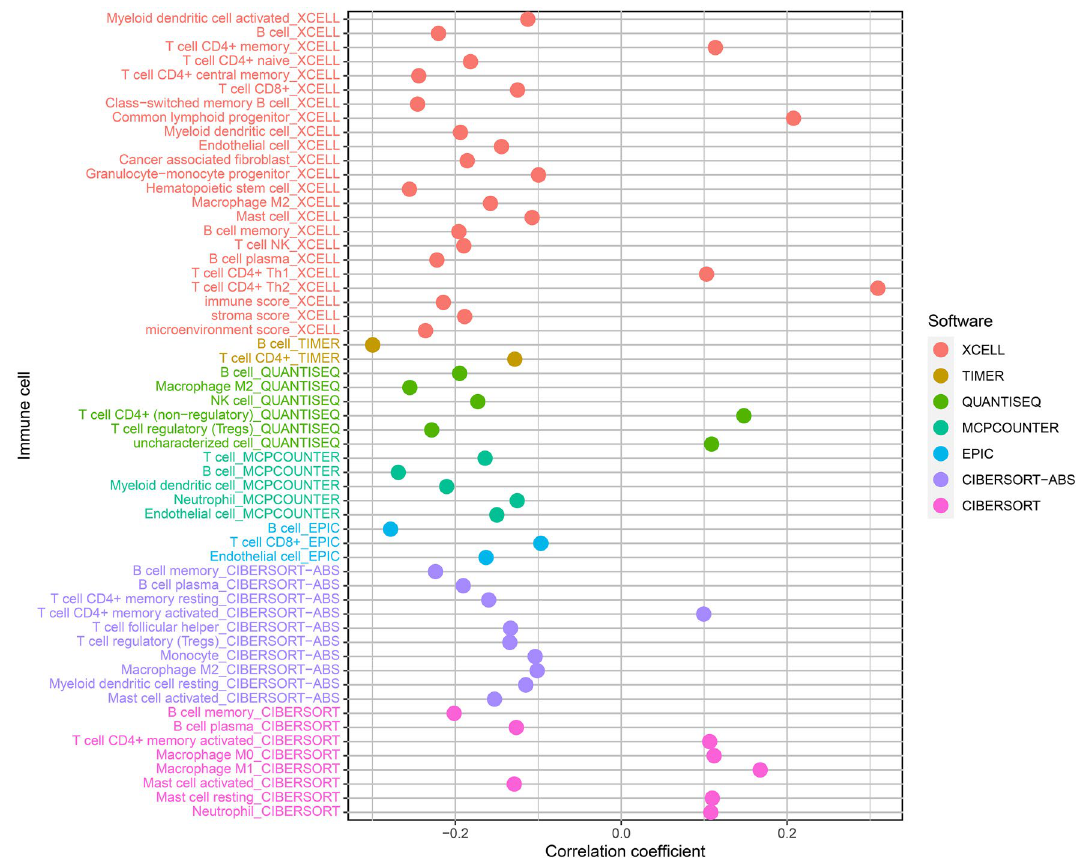
Figure 8. Correlations between immune cell infiltrations and risk score of LUAD